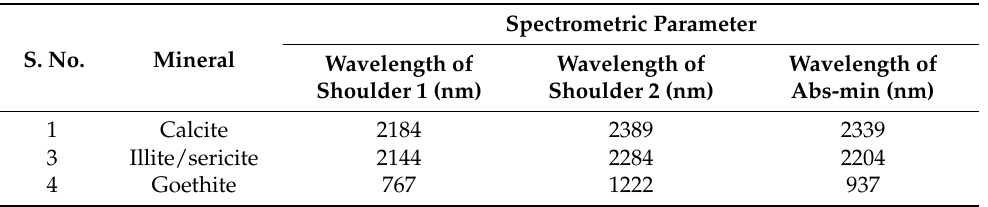
Figure 6. AVIRIS-NG spectral band resampled spectral profiles of the minerals associated with surface mineralization signatures. λ 1 to λ 4 refers to the absorption features of different minerals. λ 1 = wavelength minima of diagnostic spectral feature of kaolinite. λ 2 = wavelength minima of diagnostic spectral feature of sericite. λ 3 = Wavelength minima of diagnostic spectral feature of calcite. λ 4 = wavelength minima of diagnostic spectral feature of goethite and limonite. Table 2. Spectral bands used for deriving AVIRIS-NG-based relative band depth image for different minerals associated with alteration and supergene